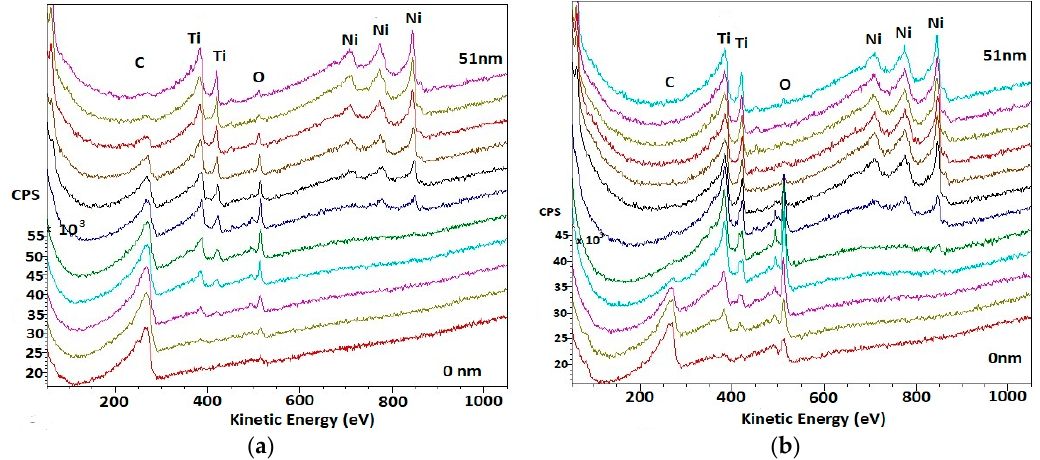
Figure 4. Auger electron spectroscopy (AES) spectra of archwire surfaces: ( a ) Initial (control); ( b ) Deformed after the SMAS simulation test.